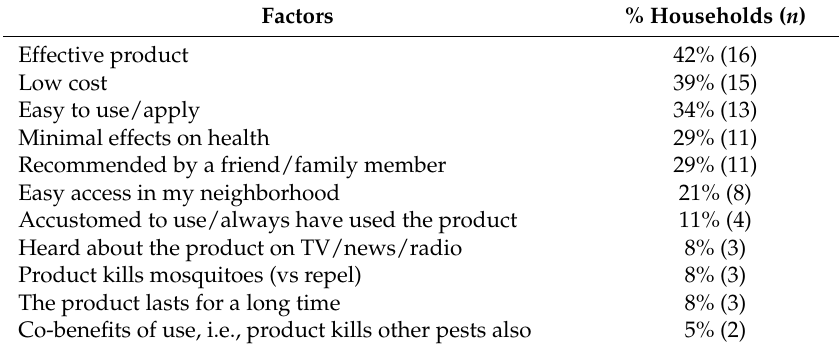
Table 5. Summary of open-ended responses regarding factors that influence the decision to purchase a mosquito-control product ( n =